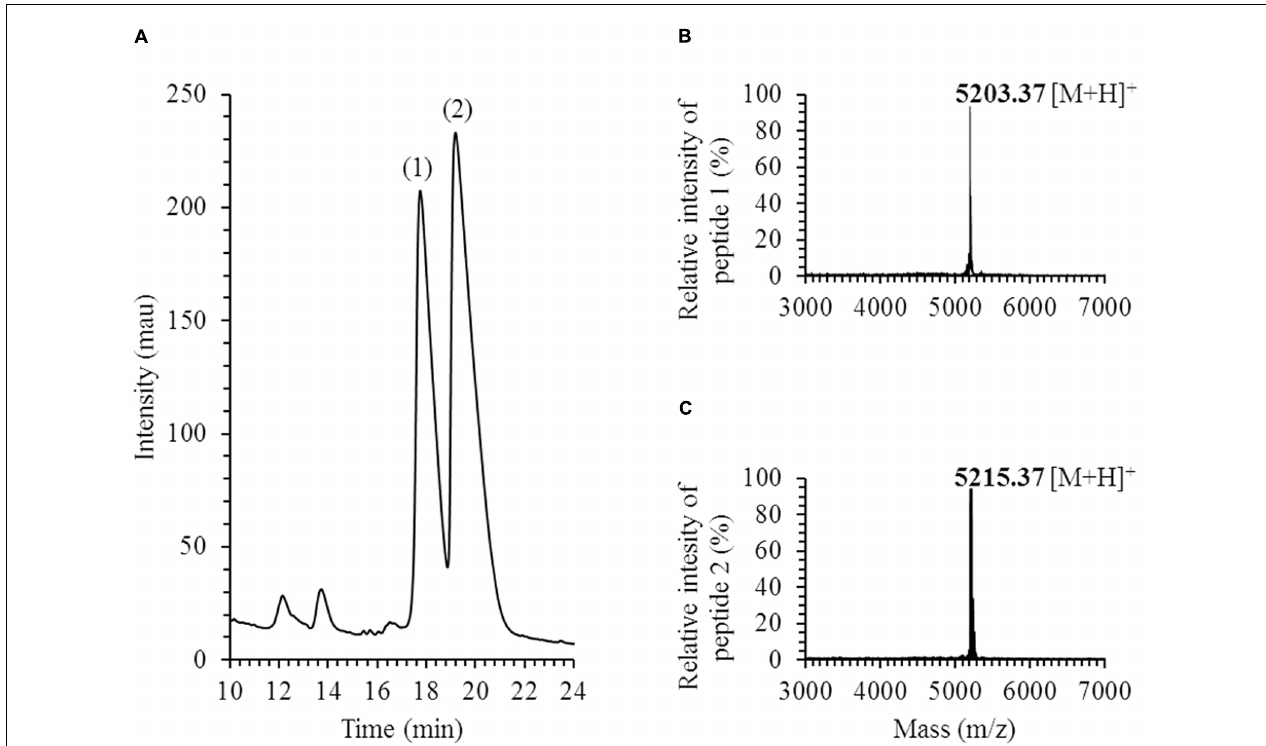
FIGURE 1 | Purification and identification of enterocins produced by Enterococcus faecium LCW 44. (A) HPLC elution profile (chromatogram) at 214 nm; (B) MALDI-TOF MS spectrum of enterocin L50B (peptide 1); (C) MALDI-TOF MS spectrum of enterocin L50A (peptide 2); mass is mono-isotopic, in